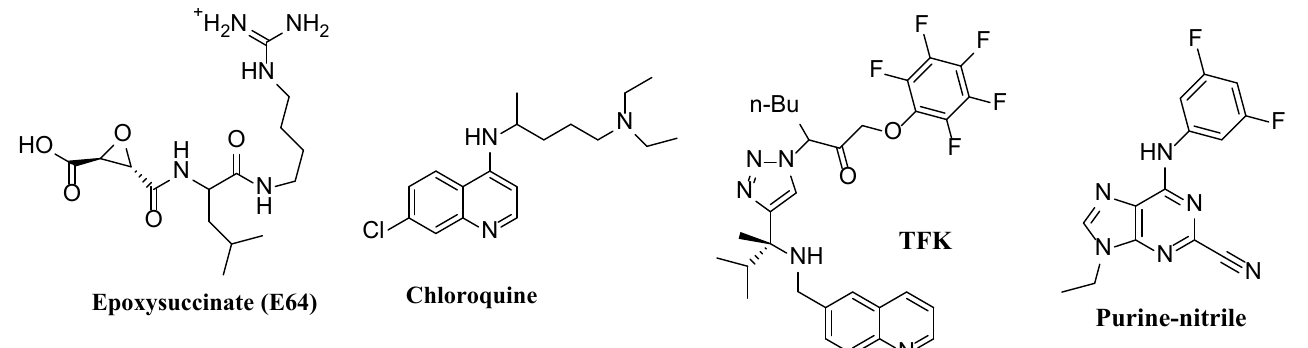
FIGURE 4 - The chemical structures of currents inhibitors used as positive control in the docking